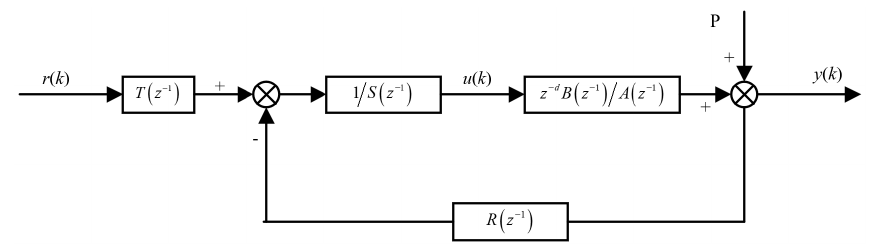
Figure 6. Block diagrams of RST